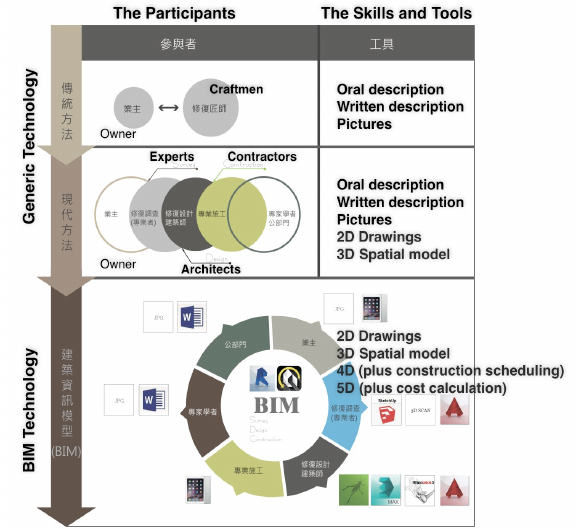
Figure 1. Conservation and application trend of historic